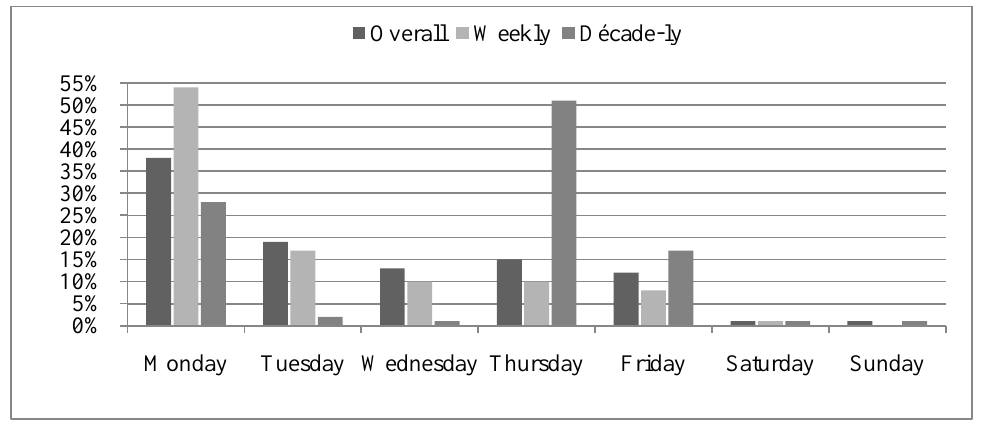
Figure 3. Percentage distribution of days on which charges are